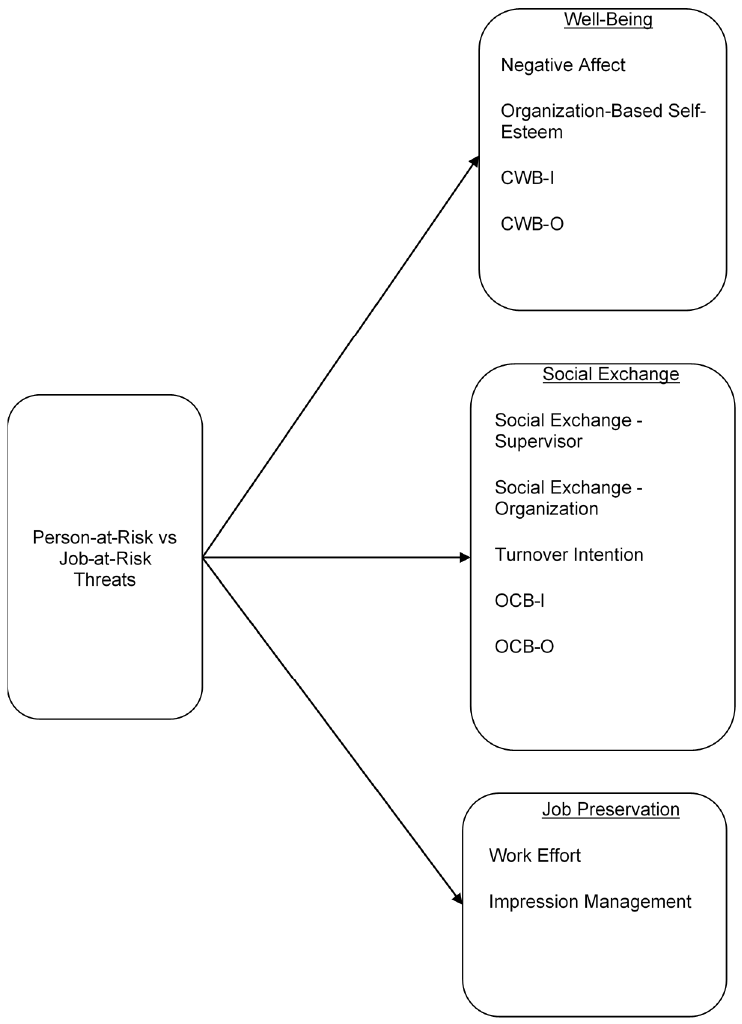
Figure 1. Conceptual model of person-at-risk and job-at-risk threats.